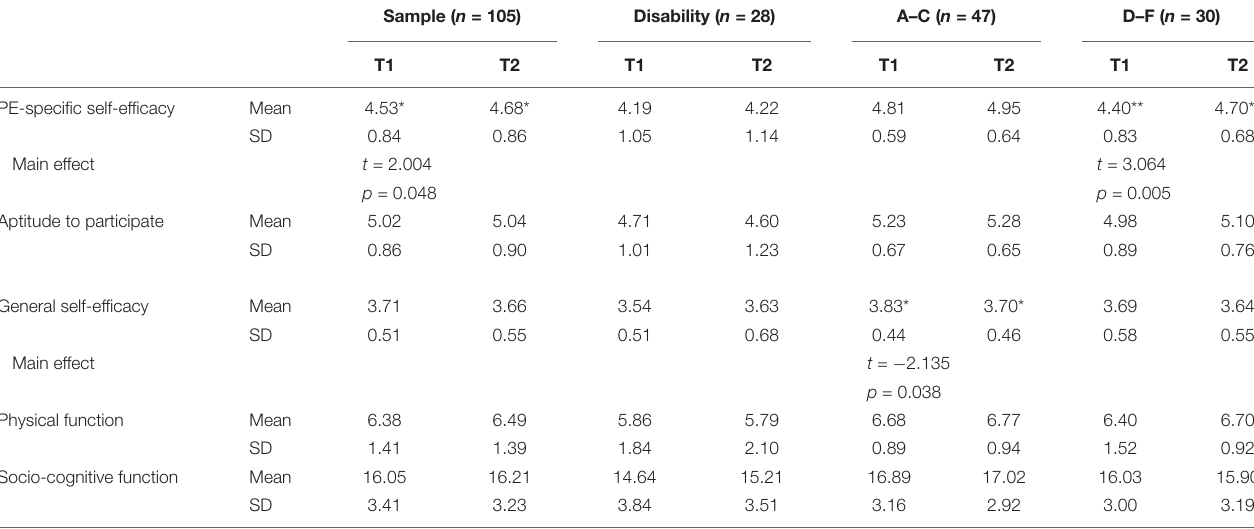
TABLE 2 | Descriptive scales in the study sample and in each group separately.